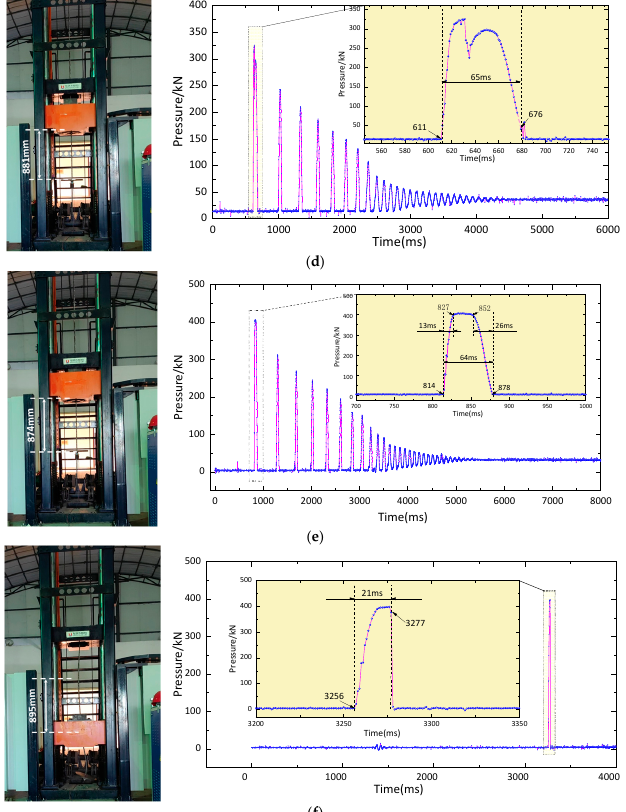
Figure 6. Impact test process of Ф 21.5 mm cable: ( a ) Ф 21.5 mm first impact process; ( b ) Ф 21.5 mm second impact process; ( c ) Ф 21.5 mm third impact process; ( d ) Ф 21.5 mm fourth impact process; ( e ) Ф 21.5 mm fifth impact process; ( f ) Ф 21.5 mm sixth impact process.